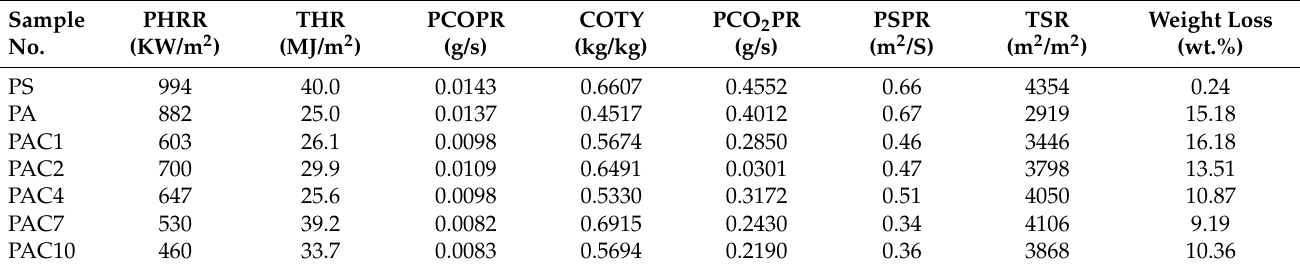
Figure 6. ( a ) SPR, ( b ) TSR, ( c ) COPR, and ( d ) CO2PR curves of PS and its composites. Table 2. The CCT data of PS and its composites at a heat flux of 35 kW/m 2